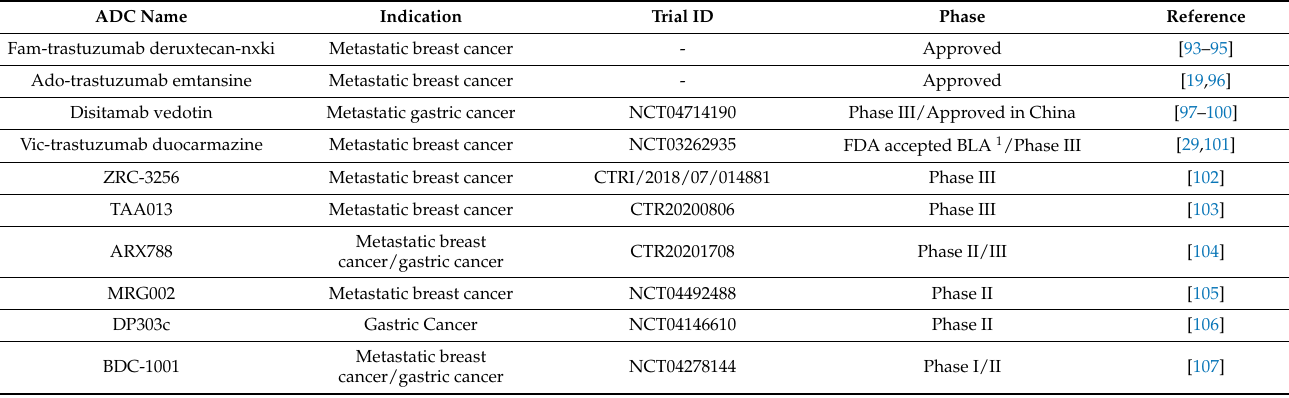
Table 2. Anti-HER2 ADCs in clinical trials or on the